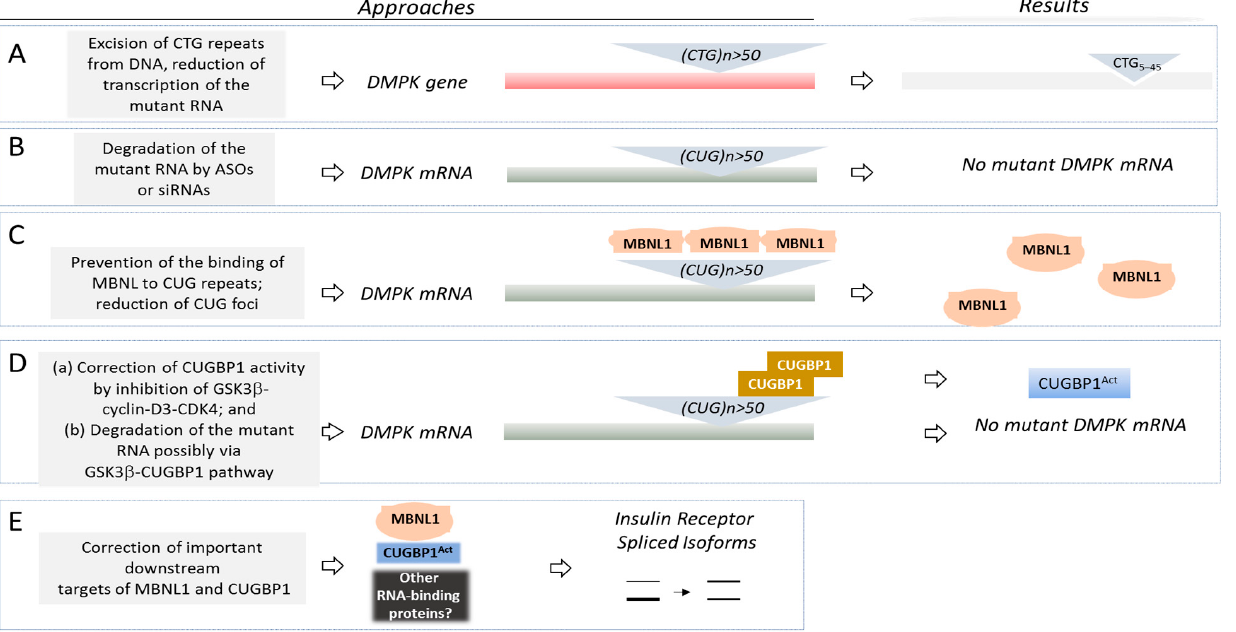
Figure 2. ( A – E ): The main therapeutic approaches for DM1 are shown. See text for details. DMPK gene and DMPK mRNA are shown as red and dark grey boxes. MBNL1 protein is shown in pink. Inactive CUGBP1 is shown in brown, while active CUGBP1 (CUGBP1 Act ) is shown in blue. Other RNA-binding proteins might participate in the regulation of MBNL1 and CUGBP1 targets in DM1.